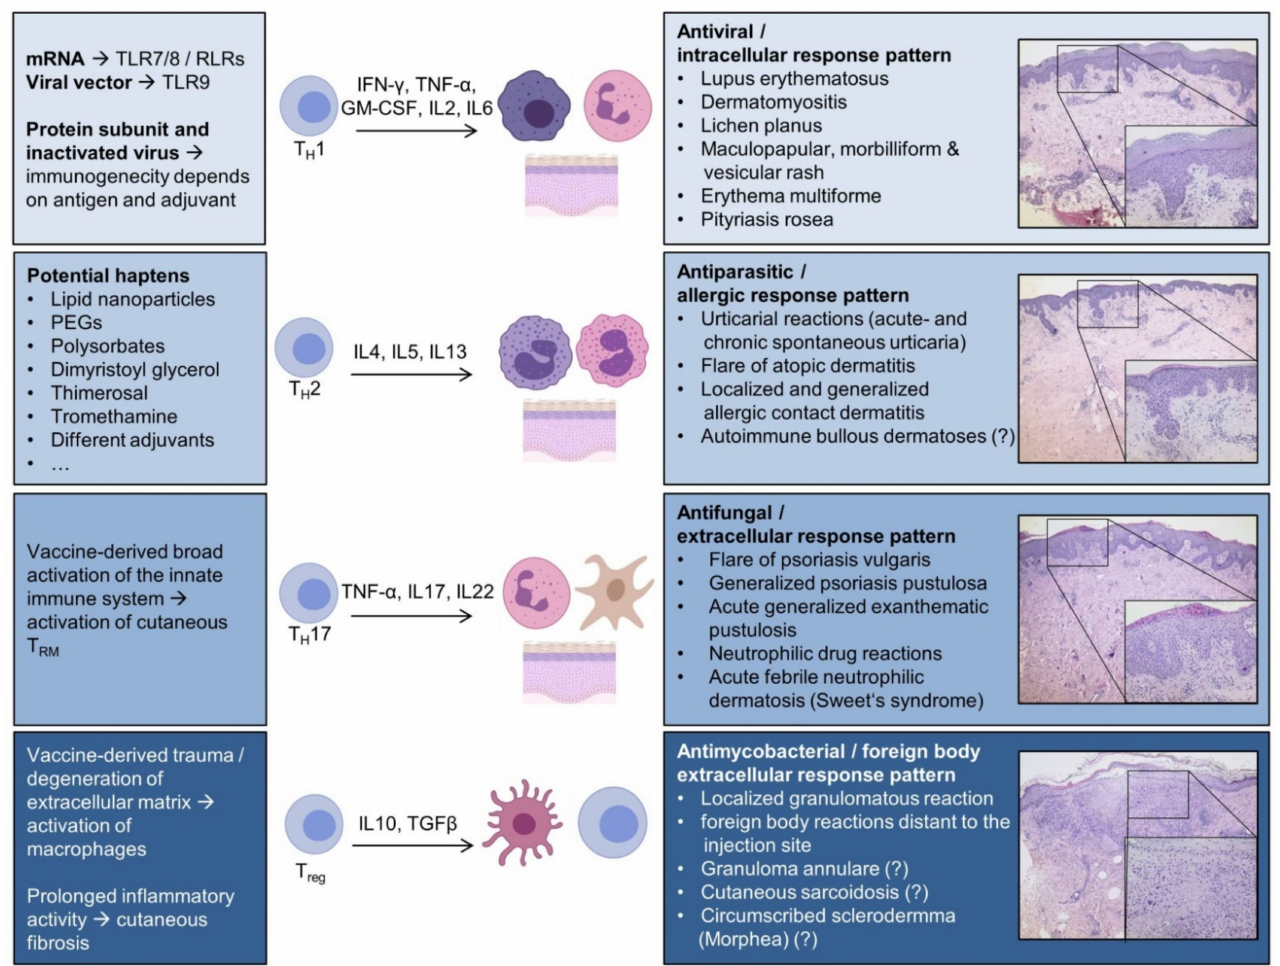
Figure 3. The mode of action varies among the different vaccine types, but it ultimately leads to increased expression of IFN- γ , which is a prerequisite for sufficient antiviral immunogenicity. Notably, mRNA and viral vector vaccines activate different TLRs; therefore, immunological differences appear plausible [36,37]. Moreover, vaccines comprise various molecules that potentially act as haptens to elicit type IV allergic reactions [38]. At this point, it is not clear whether specific vaccine types impose a larger risk for severe cutaneous ADRs to specific groups of patients, e.g., psoriatic patients. A dysregulation of regulatory T cells may shift macrophages to initiate granulomatous reactions, and longstanding inflammatory activity might induce fibrogenic alterations of the dermis to result in circumscribed scleroderma (morphea). Abbreviations: TLR—Toll-like receptor; RLR—RIG-I-like receptors; T RM —Tissue-resident memory T cell; PEG—polyethylene glycol. This immunological scheme is adapted from